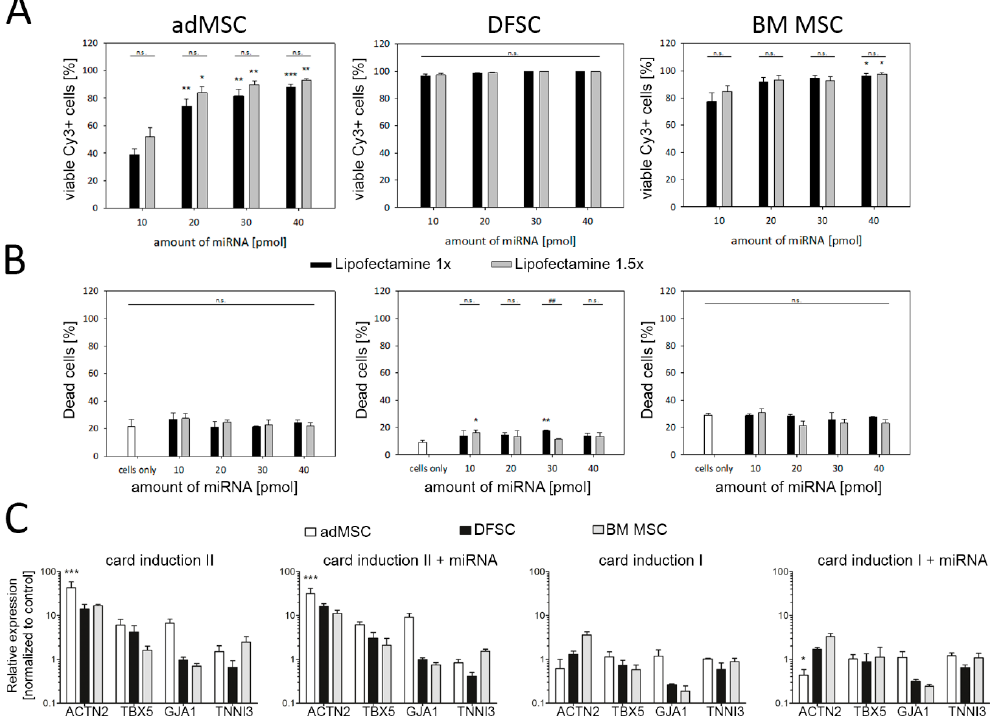
Figure 3. miRNA transfection and programming efficiency in MSC. ( A ) Uptake of miRNA was determined using Cy3-labelled miRNA and flow cytometry. ( B ) Detection of dead cells revealed low cytotoxicity induced by miRNA transfection. ( C ) Relative expression of cardiac marker genes among all tested cell types, four weeks after transfection and cultivation under different culture conditions.